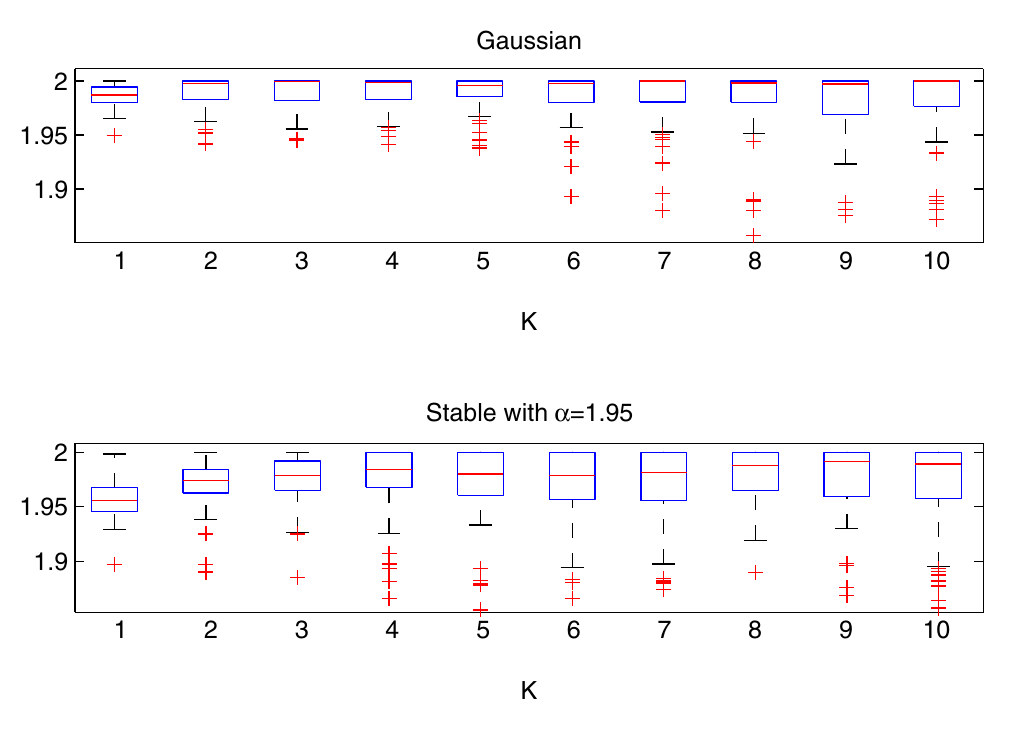
Fig 2. Estimated α values for the Gaussian sample from the top left panel of Fig 1 (top panel) and for the symmetric non-Gaussian stable sample from the top right panel of Fig 1 (bottom panel). The boxplots were constructed from 100 bootstrap samples of length 2000.